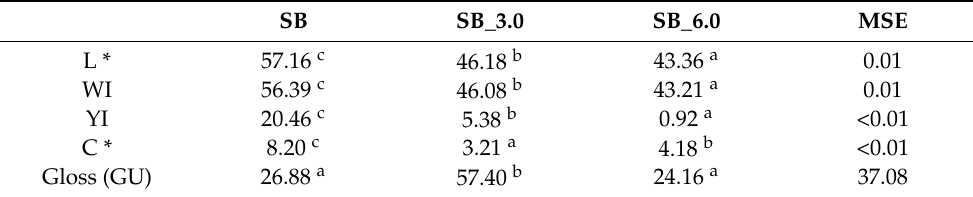
Table 5. Color and gloss of fermented soy beverage with acai powder.